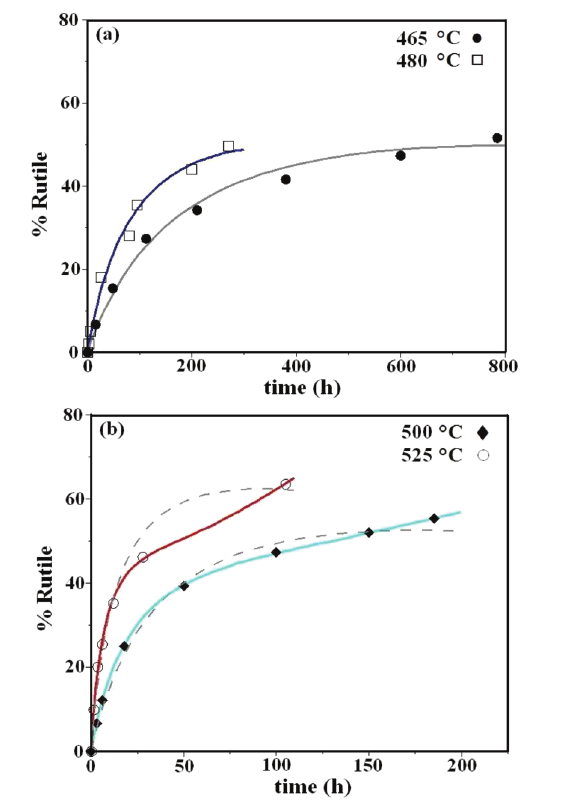
Fig. 2 – Points represent transformation experimental data from anatase to rutile 12 , and curves are fitted with (a) kinetic model (8), and (b) kinetic model (8) {dashed lines} and kinetic model (9) {solid